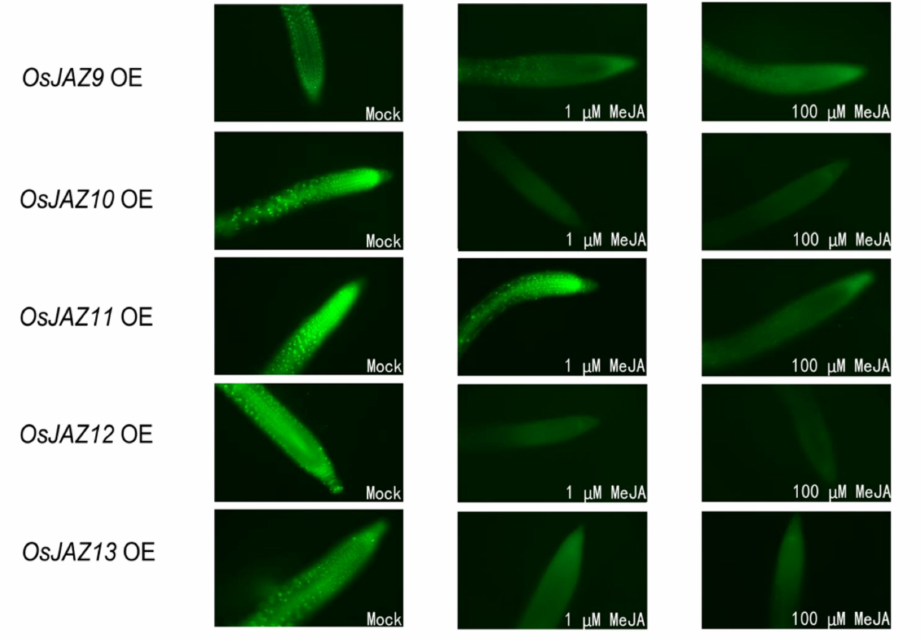
Figure 7. Hormone-dependent stability of OsJAZ9–12 in vivo. The root tips of transgenic seedlings were treated with water or subjected to the specified concentration of MeJA for two hours, after which the fluorescence intensity of the OsJAZ-GFP fusion protein was observed under a microscope. The exposure times for each of the above images were